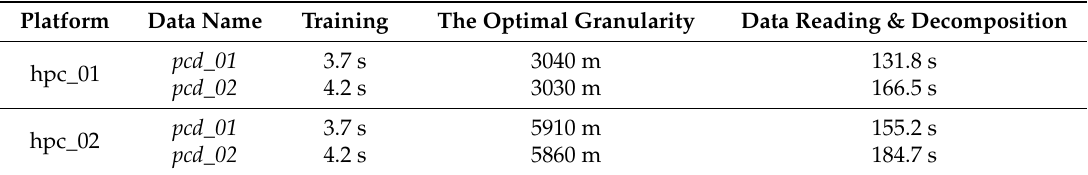
Table 4. Training time and the optimal decomposition granularities of different datasets.